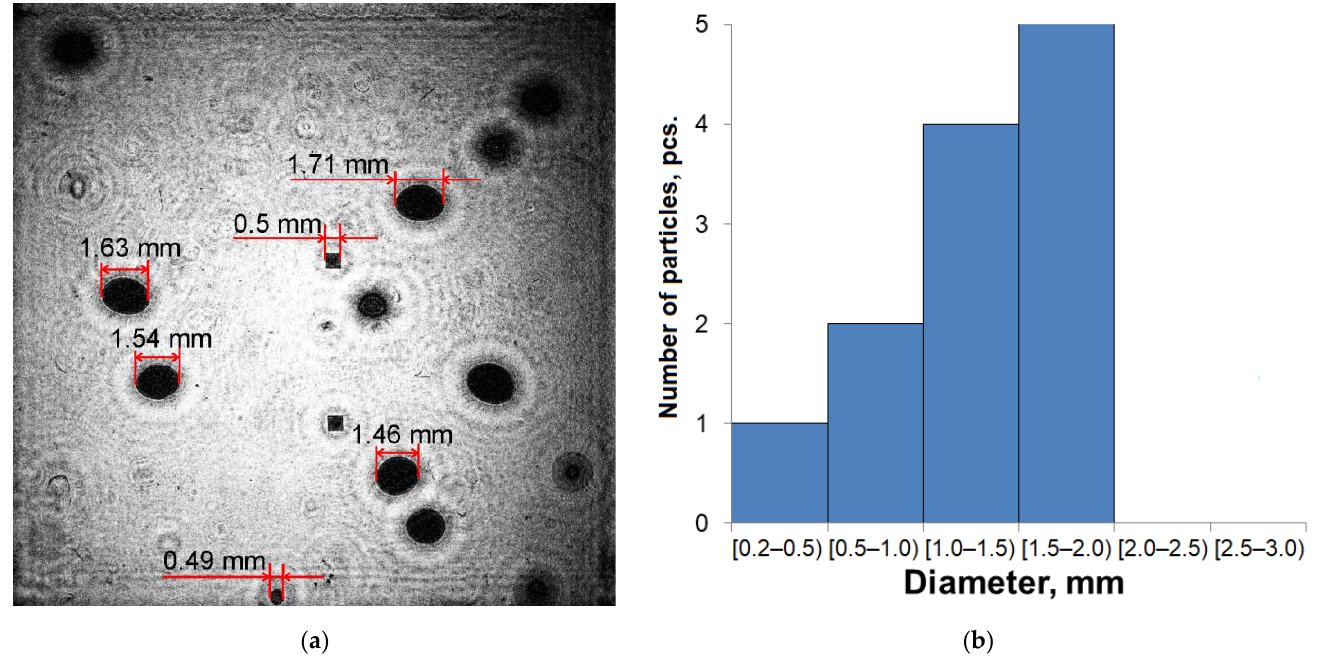
Figure 8. ( a ) Two-dimensional display of a holographic image of the studied volume with bubbles against the background of the test particles; ( b ) histogram of the distribution along the diameters of the bubbles.